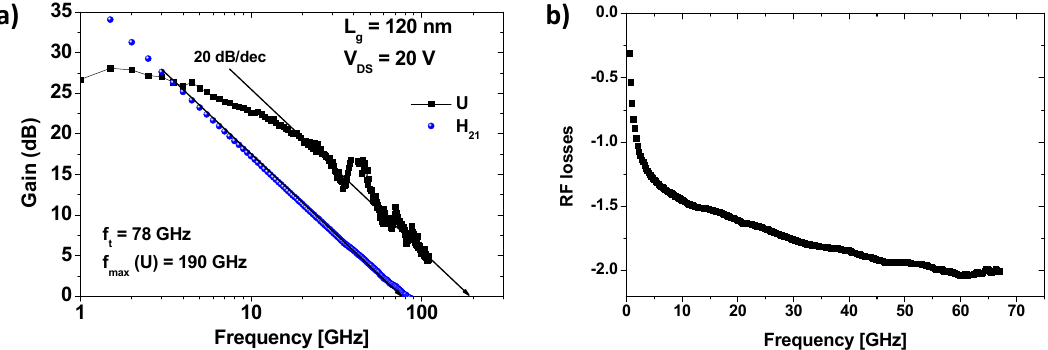
Figure 4. ( a ) RF performance of the 0.12 × 50 µm 2 AlN/GaN HEMT on silicon substrate at V DS = 20 V; ( b ) RF losses extracted from transmission lines up to 67 GHz.